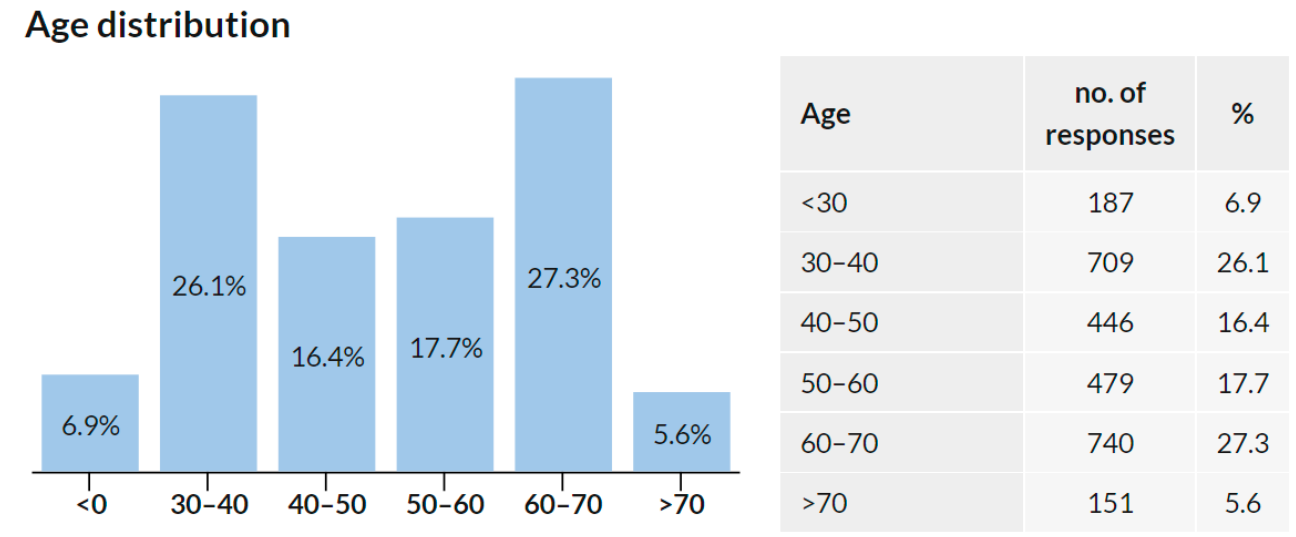
Figure 3. Age distribution of the study participants.